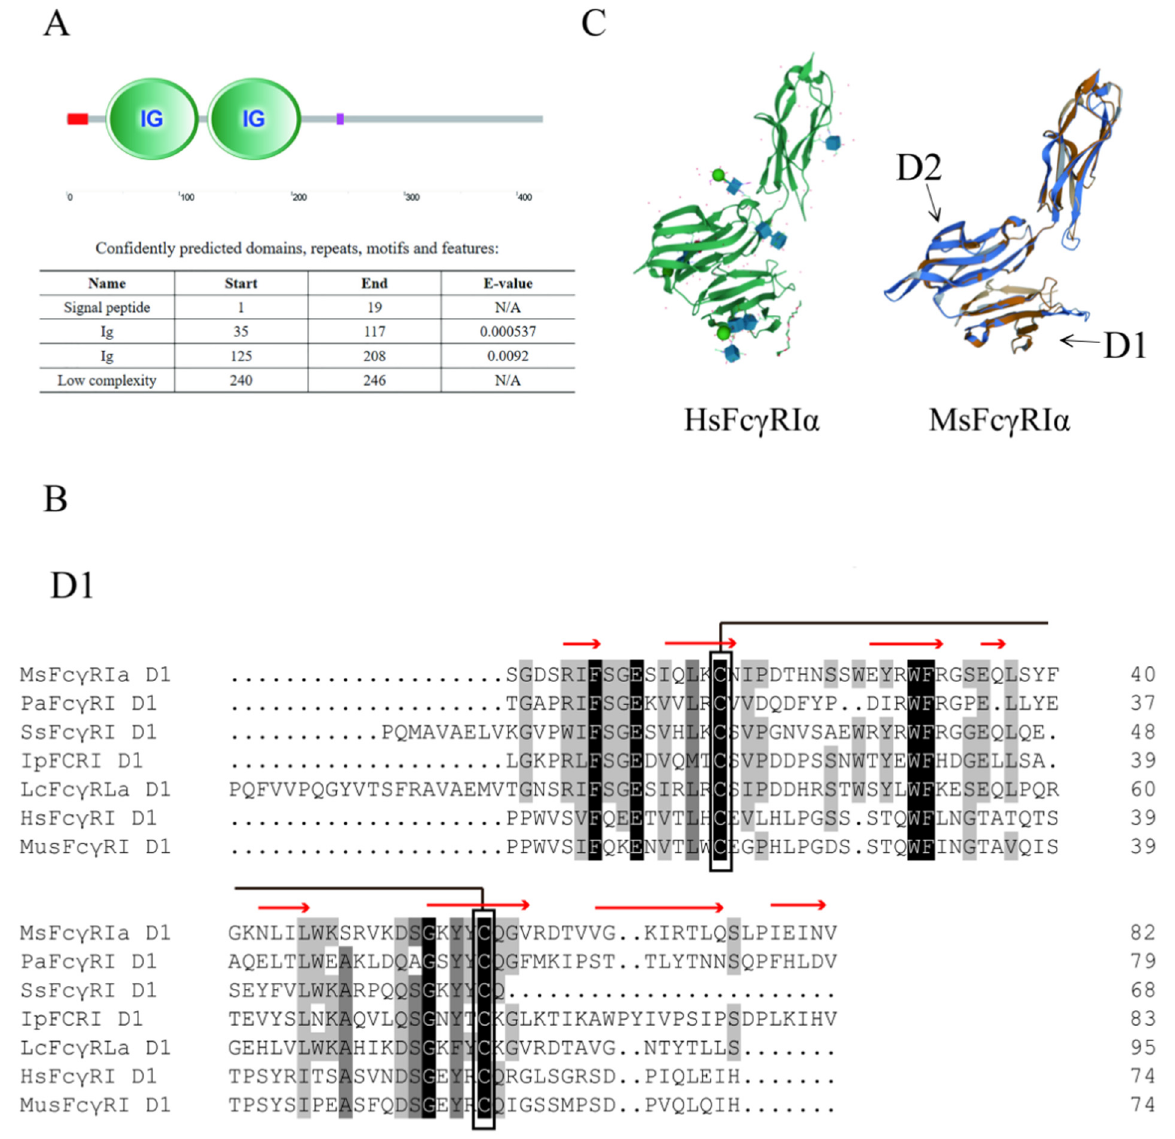
Figure 1. Nucleotide and deduced amino acid sequence of MsFc γ RI α (GenBank accession No. OK258092) . The predicted signal peptide domain is shaded in gray, and two Ig domains are indi- cated with red underlines. The solid black dot highlights a potential N-linked glycosylation site. The start codon (ATG) and stop codon (TAA) are marked with black boxes, and the stop codon was also illustrated as